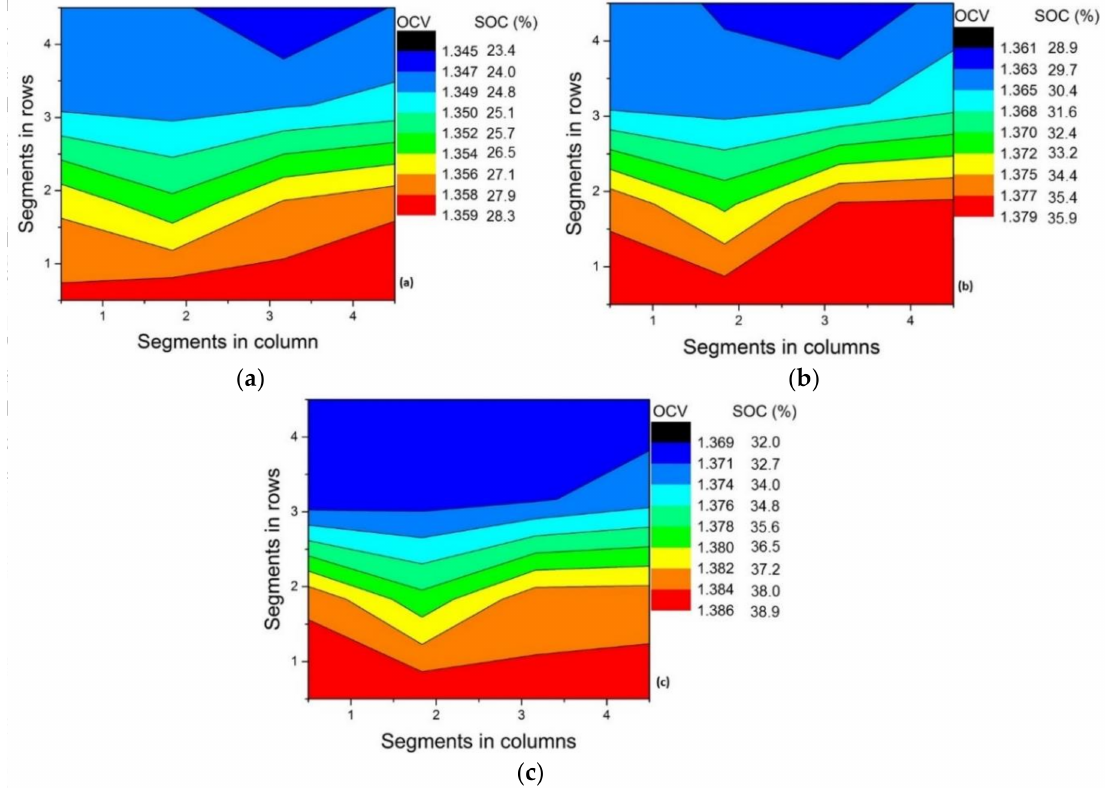
Figure 4. OCV/SOC contours at 5 s after termination of discharge at 80 mA cm − 2 . The flow rate of electrolyte was ( a ) 16 mL min − 1 , λ = 1.3 ( b ) 32 mL min − 1 , λ = 2.6 and ( c ) 42 mL min − 1 , λ = 3.4.